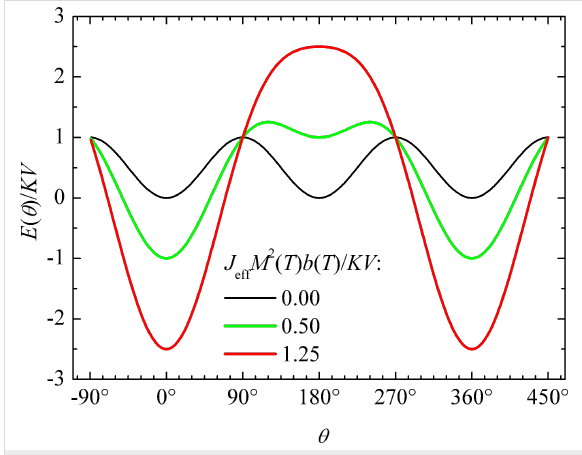
Figure 5: The normalized magnetic energy, E ( θ )/ KV (Equation 9) for different values of the ratio between the interaction energy J eff M 2 ( T ) b ( T ) and the anisotropy energy, KV